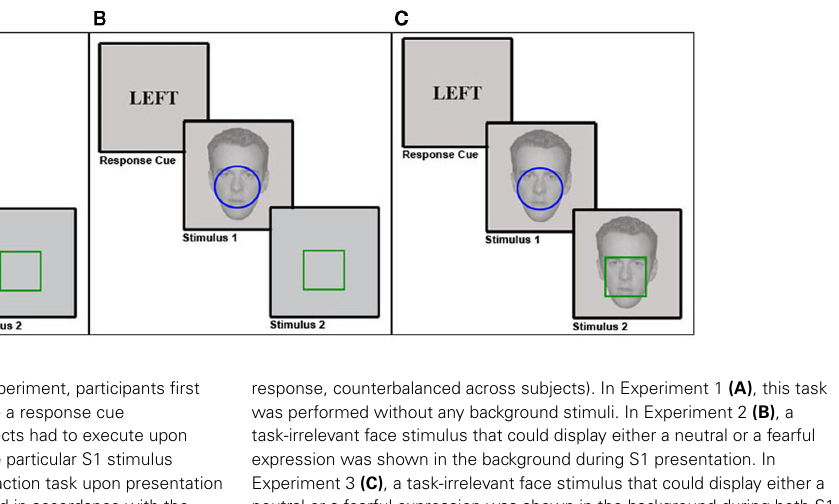
FIGURE 1 | Experimental protocols. In each experiment, participants first performed a delayed simple reaction task, where a response cue pre-determined the response (left vs. right) subjects had to execute upon presentation of stimulus 1 (S1), regardless of the particular S1 stimulus features.This was followed by a binary-choice reaction task upon presentation of stimulus 2 (S2), where subjects had to respond in accordance with the color of a colored shape stimulus (e.g., blue = left response, green = right